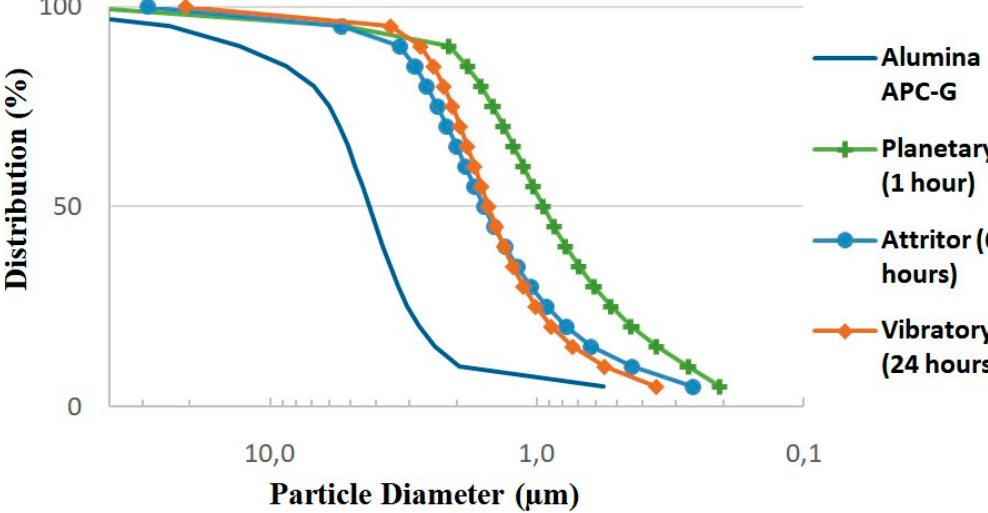
Figure 10. Particle size distribution of alumina powder before grinding, 24 g of alumina after 1 hour in the planetary mill, 100 g of alumina after 6 hours in the attritor mill and 24 g of alumina after 24 hours in the vibratory mill.